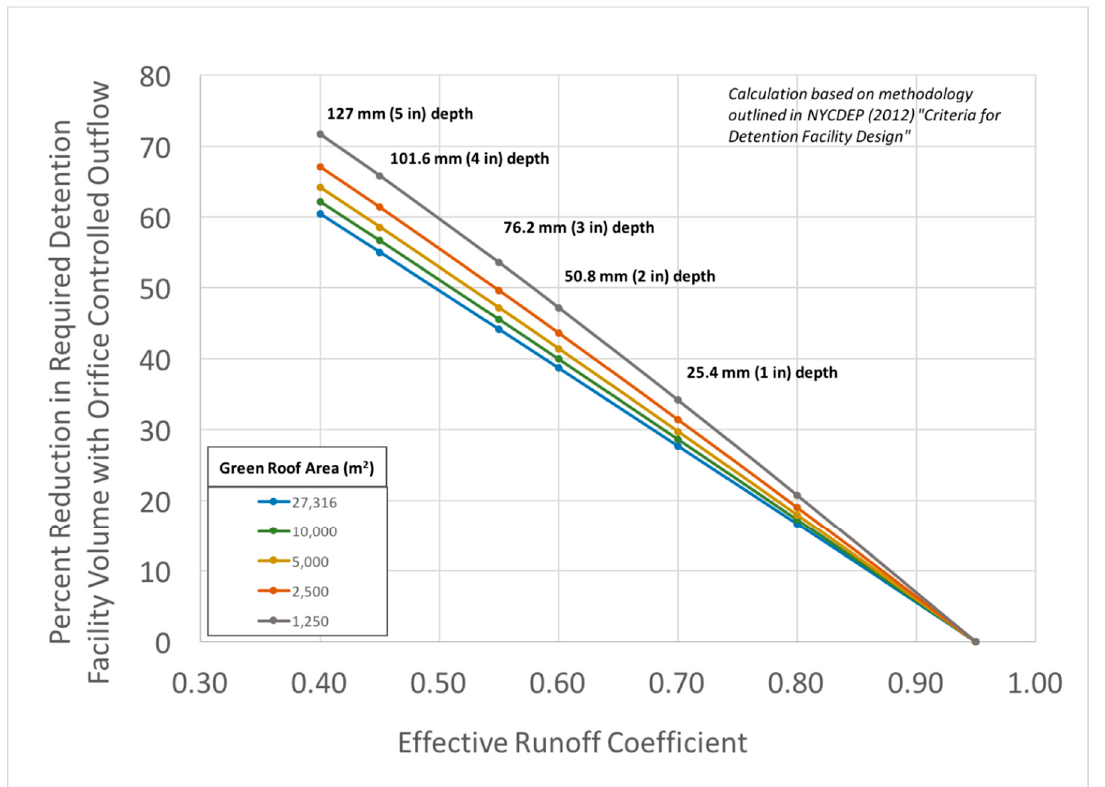
Figure 13. Required detention facility volume to replace different sized green roofs.